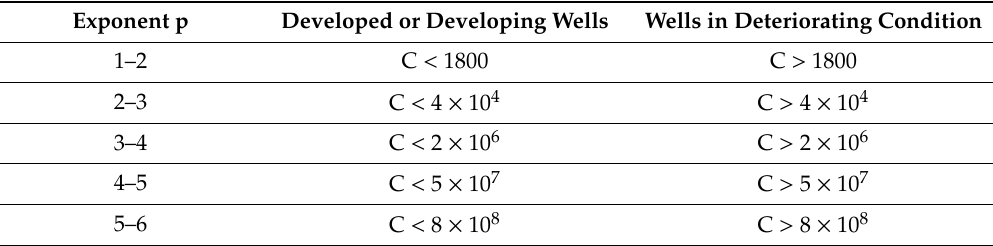
Table 3. Tabulated General Well E ffi ciency Criteria